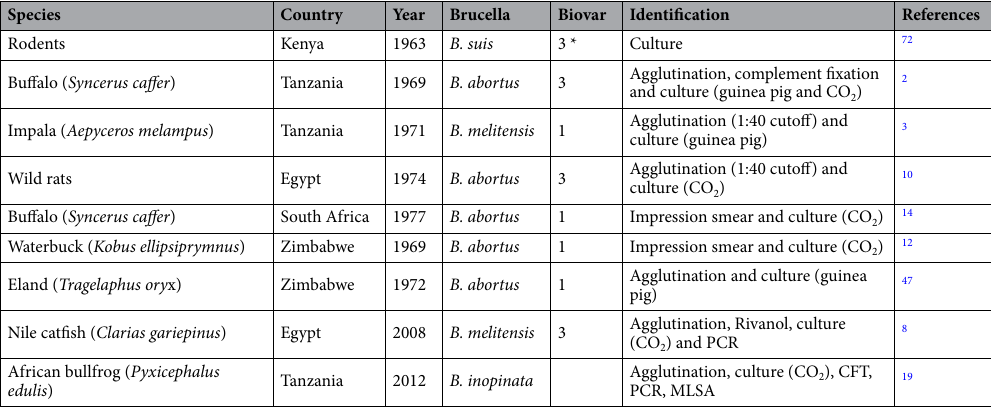
Table 1. Brucella spp. isolation studies in Africa with biovar, year of study, country, method of identification and references. CFT complement fixation test, PCR polymerase chain reaction, MLSA multilocus sequence analysis. *Possible misclassification because the species and the biovar were ascribed by phenotypic characterization only.